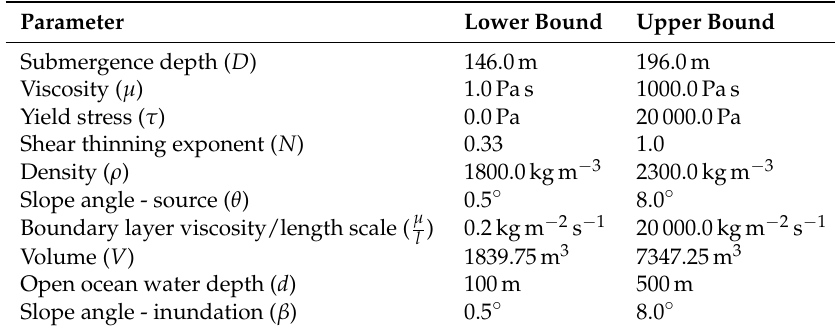
Figure 1. Geometry for training dataset. The variables D , θ , d , and β shown in the sketch are described in Table 1. The distance from the left hand side of the Smooth Particle Hydrodynamics (SPH) domain to the mid-point of the slide averages 582m is shown, but varies slightly with the slope angle θ . The SPH simulation domain is shown along with a sketch of the idealised geometry assumed for our run-up approximation (Section 2.5.2). Table 1. Input parameter bounds. The first eight parameters pertain to the SPH simulations. The final two are used in the run-up approximation calculation described in Section